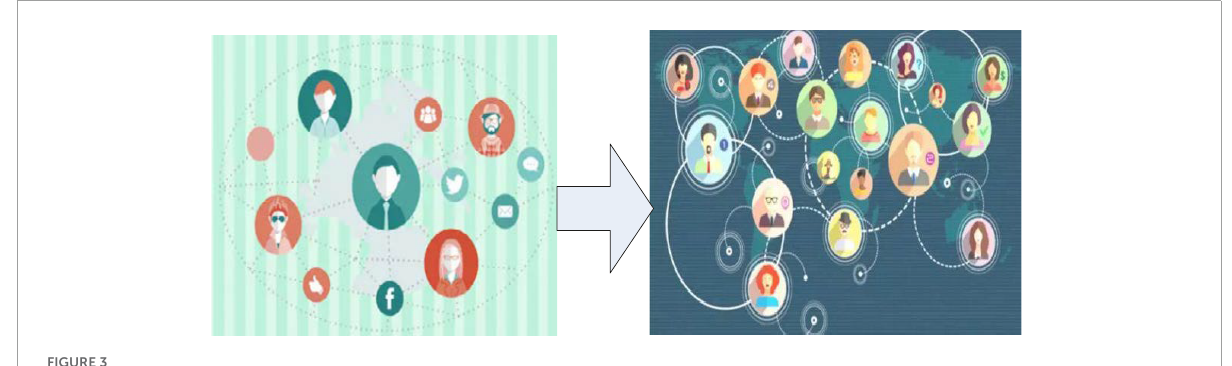
FIGURE3 Crowd social network